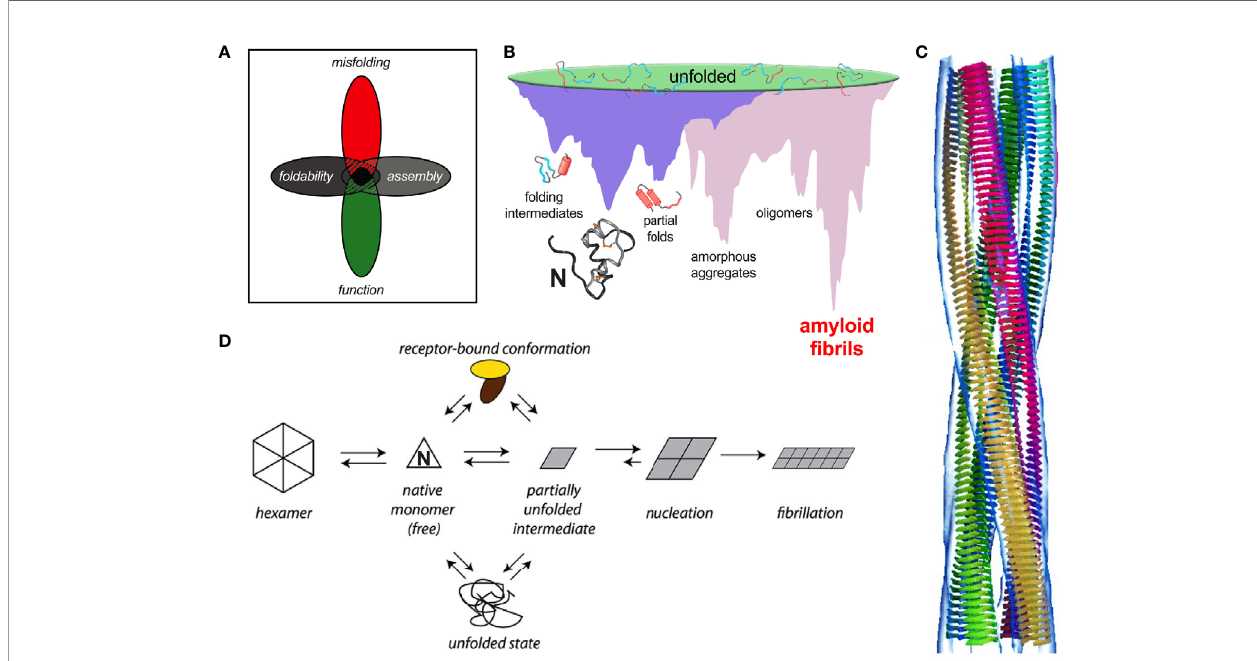
FIGURE 8 | Evolutionary constraints and insulin fi brillation. (A) Venn diagram showing intersection of multiple constraints: function, foldability, misfolding, and assembly (183). (B) Energy landscape of protein folding (purple) and coupled landscape of aggregation (pink) (184). Cytotoxic oligomers may form as off-pathway intermediates en route to amyloid. (C) Models of proto fi lament packing based on low-resolution cryo-EM images. The image is reproduced from the reference (185), Copyright (2002) National Academy of Sciences. (D) General scheme of insulin fi brillation via a partially unfolded monomeric intermediate (parallelogram at center) (186). The native state (triangle) is protected by classic self-assembly (far left). Disassembly leads to an equilibrium between native and partially folded monomers. The receptor-bound conformation of insulin (top) may also participate in this equilibrium. This partial fold may unfold completely (bottom) as an off-pathway event or aggregate to form an amyloidogenic nucleus en route to a proto- fi lament